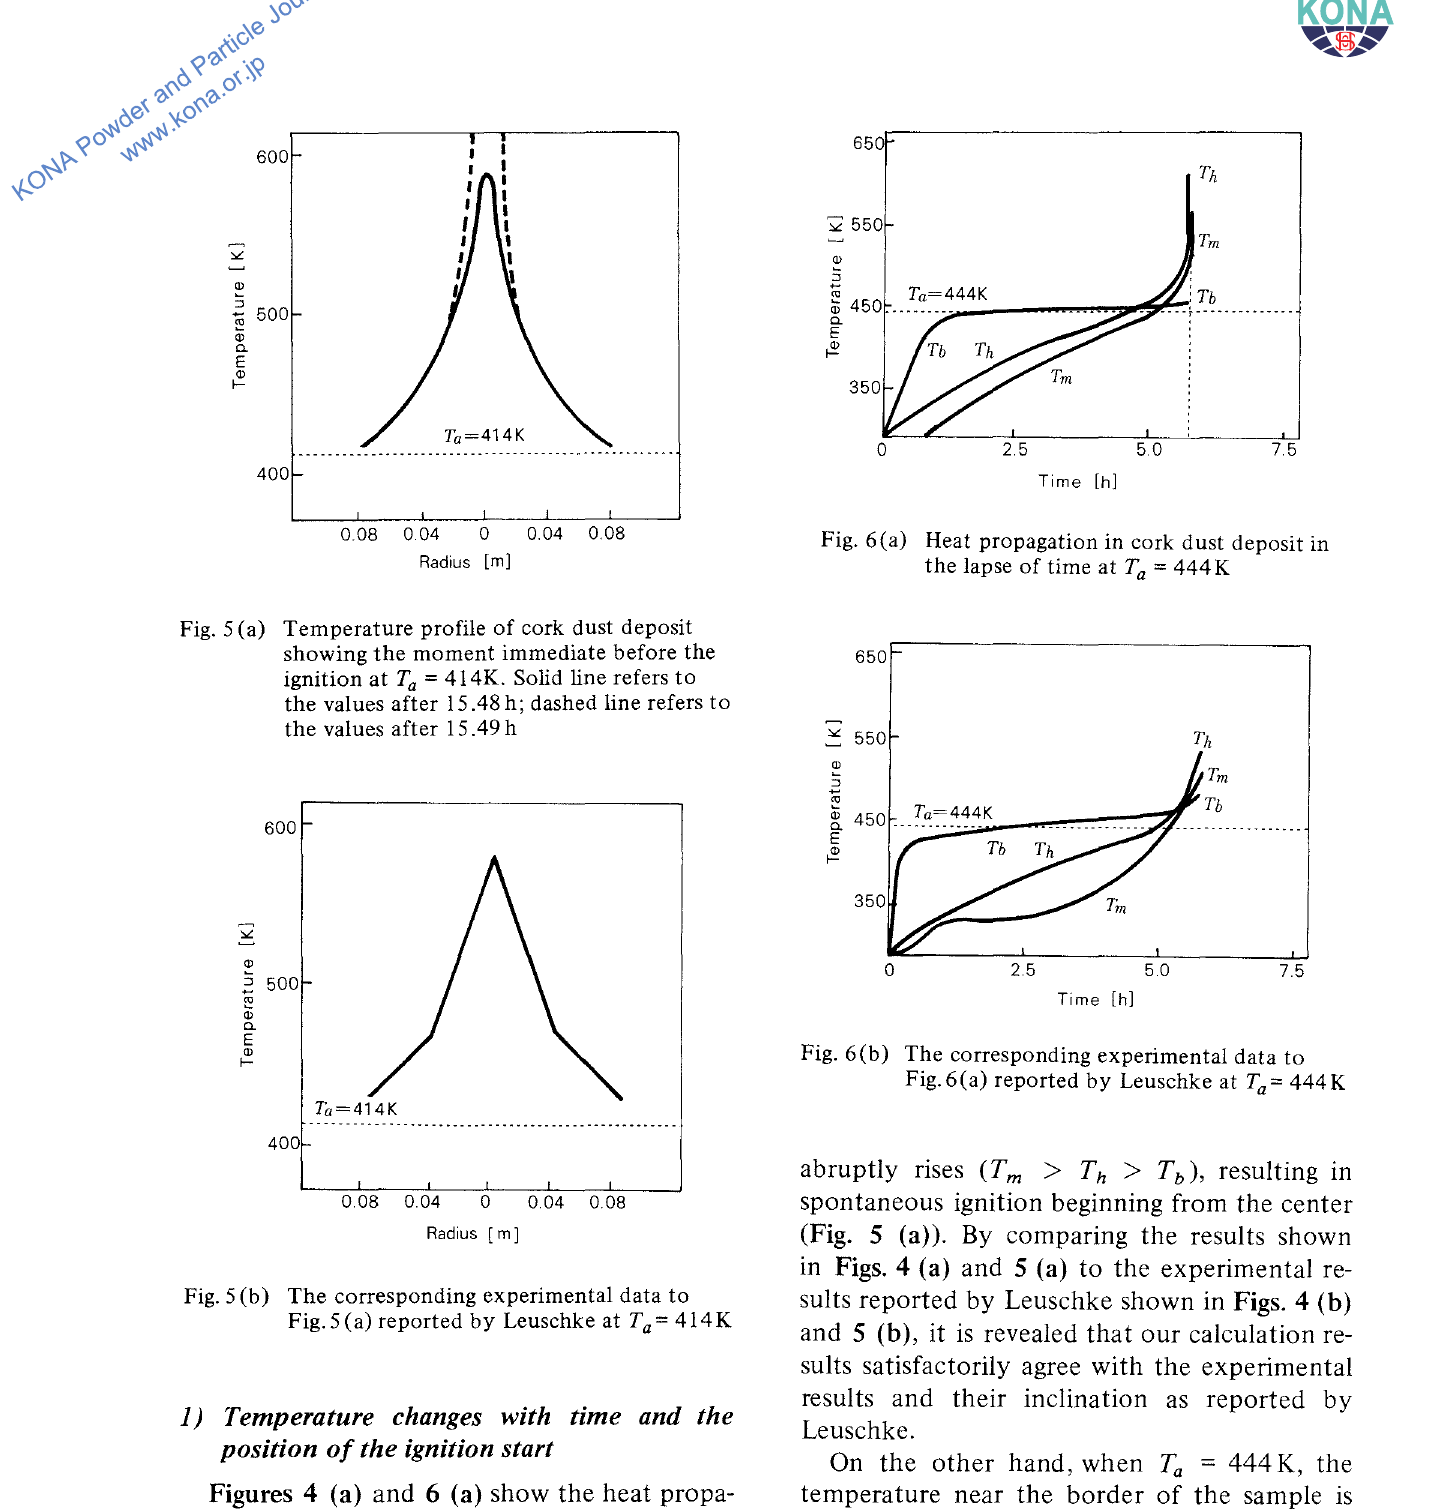
Fig. 5 (b) The corresponding experimental data to Fig. 5 (a) reported by Leuschke at Ta = 414K